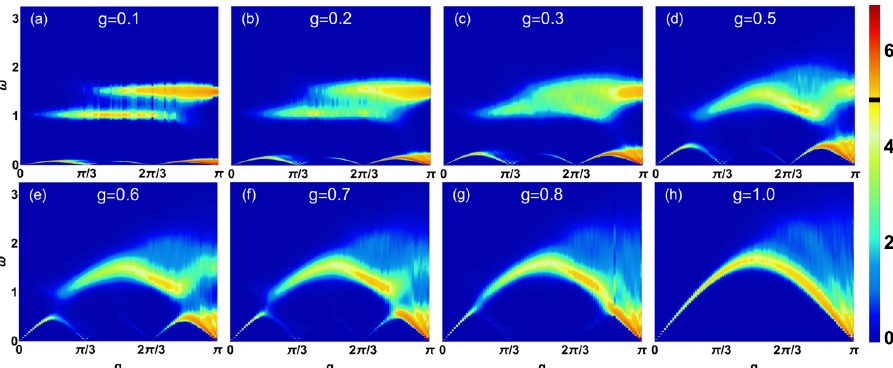
Fig. 2 Dynamic spin structure factor S ð q ; ω Þ obtained from QMC-SAC calculations for different g values. The color coding of Sð q ; ω Þ , illustrated with the bar on the right side, uses a piecewise function where the boundary value U 0 = 5 is indicated by the line on the color bar. Below the boundary, the low-intensity portion is characterized by a linear mapping of the spectral function to the color bar, while above the q ; ω Þ(cid:3) (cid:5) log U 0 Þ . Since the SAC method generates spectra with intrinsic broadening, boundary a logarithmic scale is used, U ¼ U 0 þ log 10 ½Sð 10 ð no additional broadening is imposed here. The vertical striped features, noticeable especially between the ω ≈ 1 and ω ≈ 1.5 bands in ( a ) and ( b ), are typical in analytic continuation when the statistical precision of the QMC imaginary-time data is barely suf fi cient for resolving two features, thus not completely resolving them for some momenta while resolving them in other cases ( c ) – ( h ).